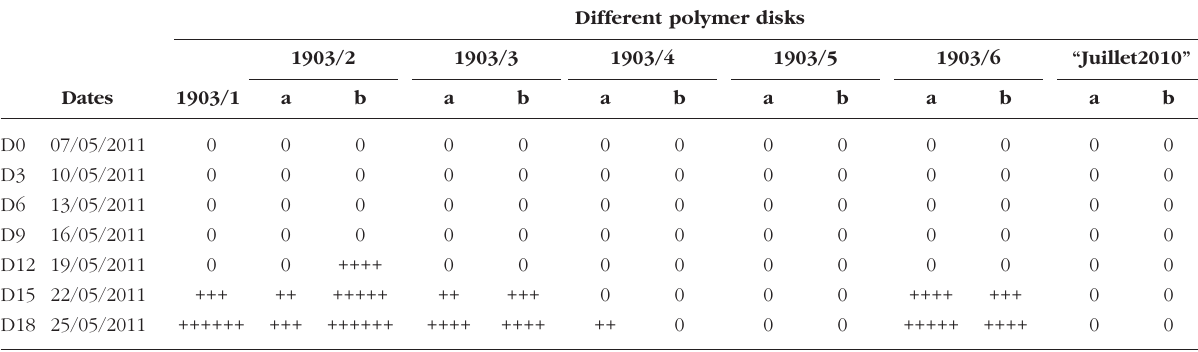
Table IV bis. – Experiment C: presence and abundance of Ae. albopictus larvae in saucers with different geraniol impregnated polymer disks in an infested area, one month after the previous test using the same disks.